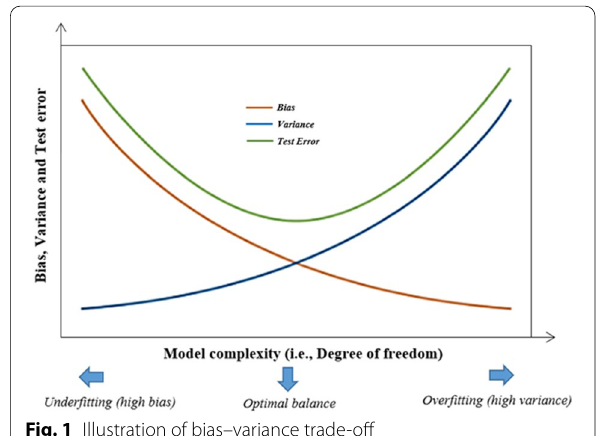
Fig. 1 Illustration of bias–variance